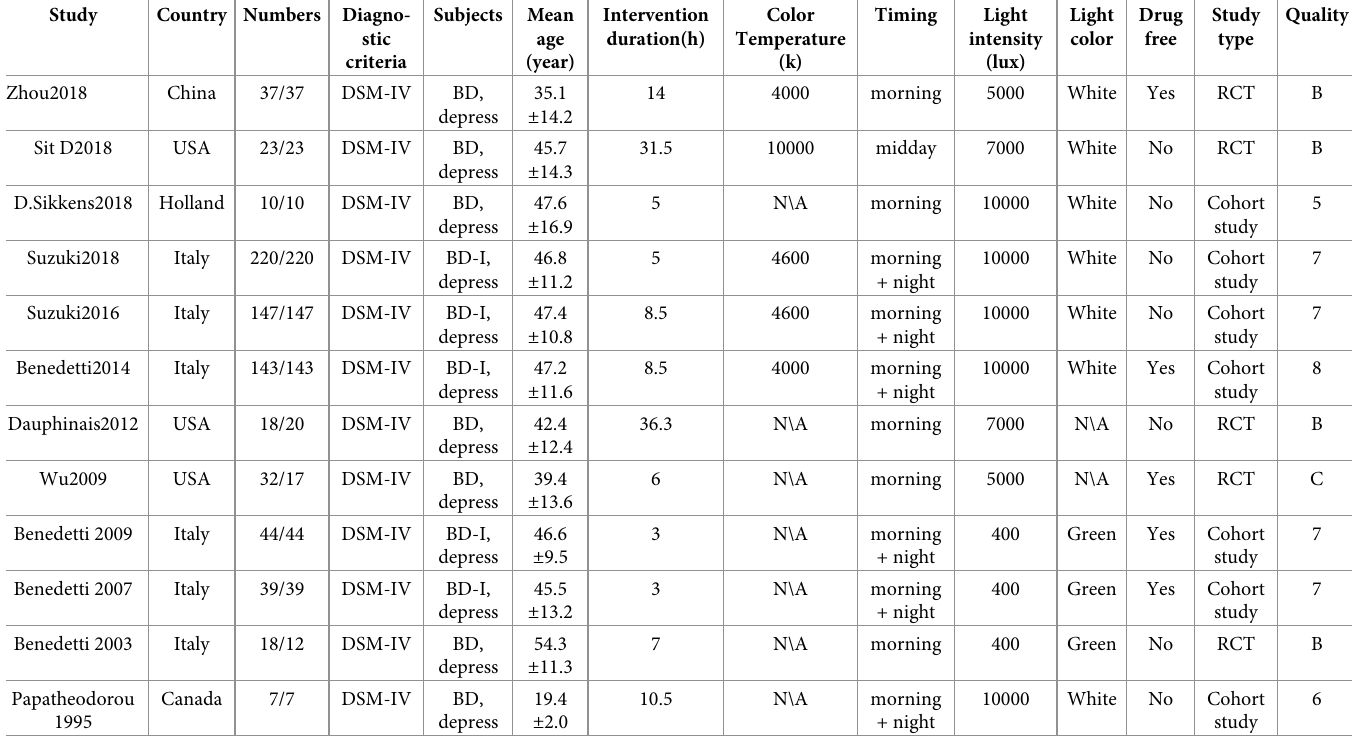
Table 1. Characteristics and quality assessment result of the included